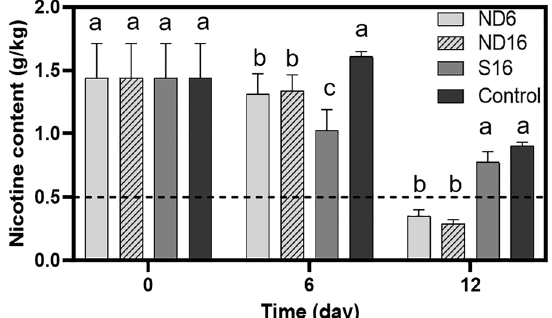
Fig. 6 Addition of nicotine-degrading bacteria ND6 and ND16 on nicotine degradation in compost fertilizer fermented from tobacco